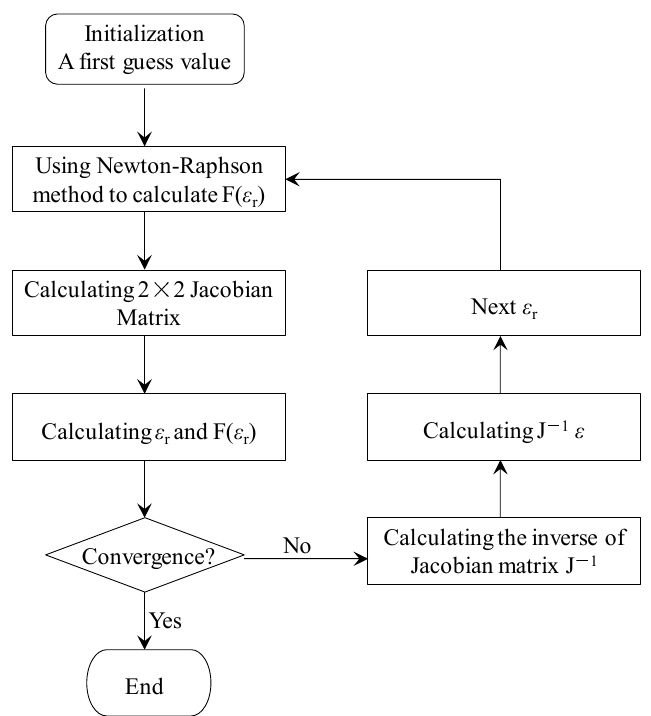
Figure 6. The flow chart of Newton–Raphson method solving for the permittivity.